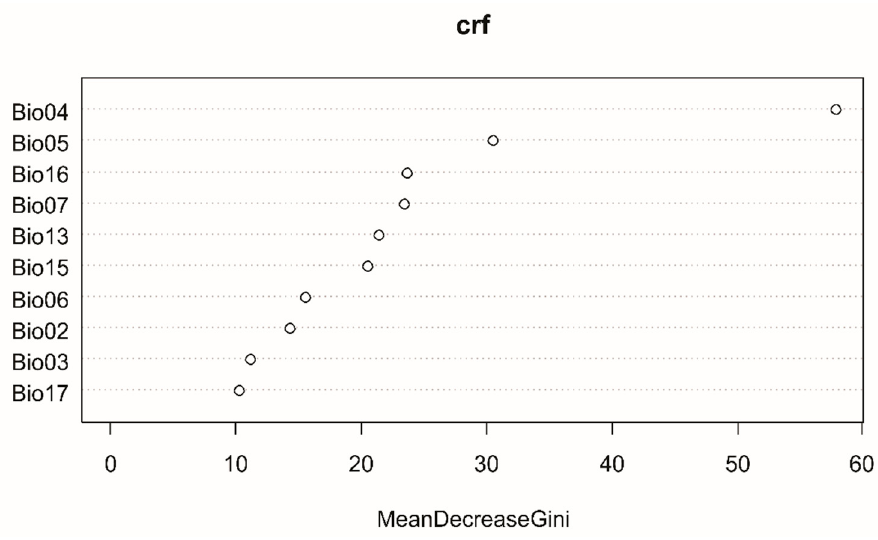
Figure 3. Potential spatial distribution of Pinus oocarpa using logistic regression.